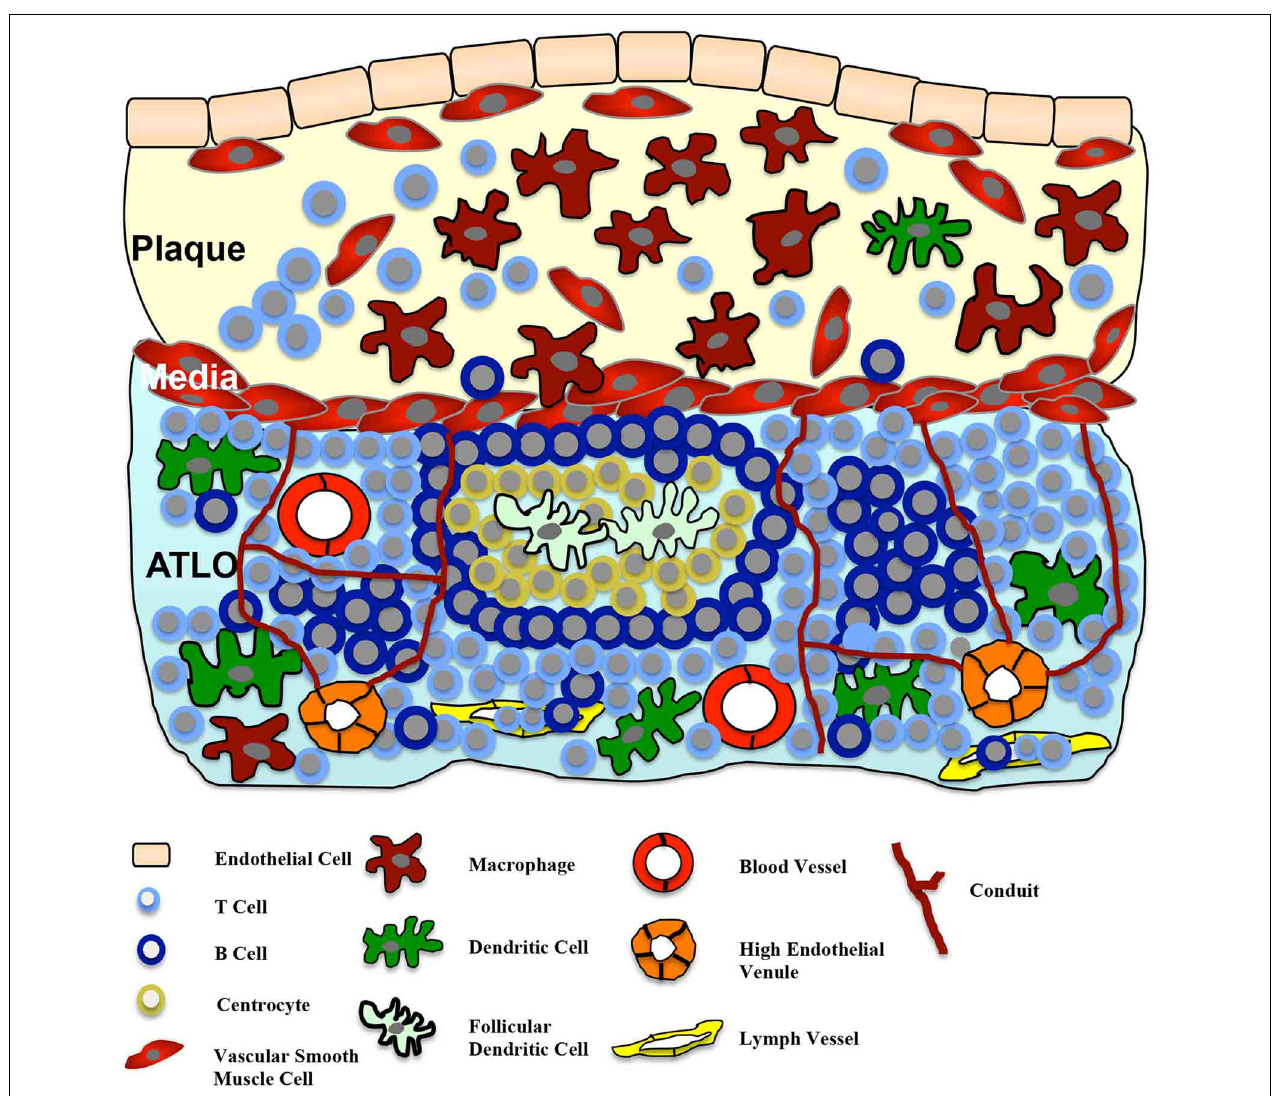
FIGURE 1 | Adventitial tertiary lymphoid organs (ATLOs) in atherosclerosis. The cellularity and structure of ATLOs in the diseased vessel wall is presented. ATLOs represent organized accumulation of different lymphoid cells, developed in response to the chronic inflammatory process of atherosclerosis. Stage III ATLOs show T and B cell areas. Germinal centers withfolliculardendriticcellssurroundedbycentrocytesandBcellsarepresent.